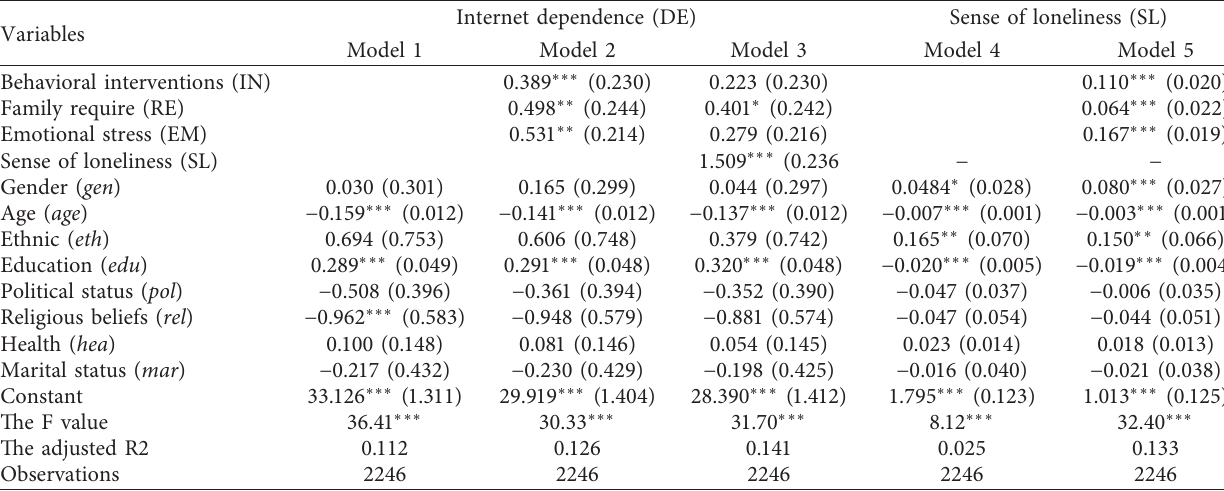
Table 4: Test of the relationship between family stress, sense of loneliness, and the degree of Internet dependence.